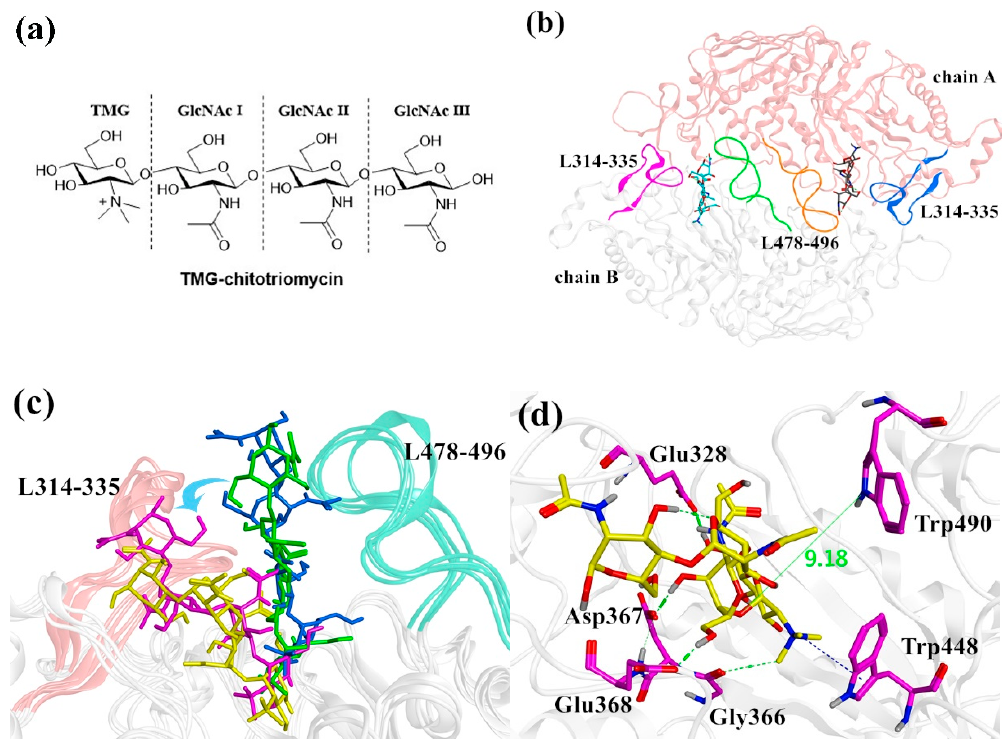
Figure 1. ( a ) The structure of N,N,N -trimethyl- D -glucosamine-chitotriomycin (TMG-chitotriomycin). ( b ) The homodimer structure of the TMG-chitotriomycin-O f Hex1 complex. The loop L478-496 is stable because of the numerous interactions. ( c ) Structure comparison of conventional molecular dynamics (CMD)1 (yellow), CMD2 (blue), CMD3 (purple), and crystal complex (green). ( d ) A close view of TMG-chitotriomycin bound in O f Hex1 from CMD1. Important residues are marked in purple.